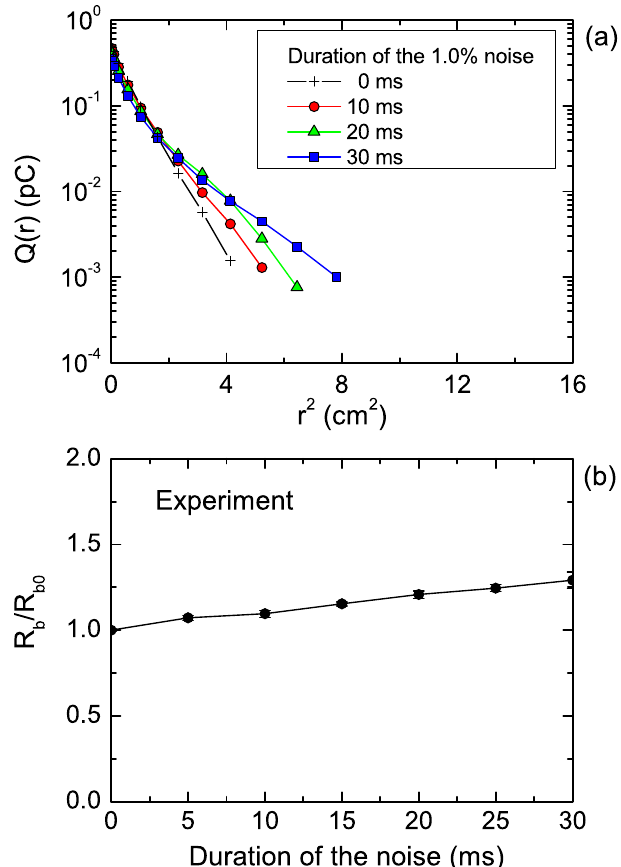
FIG. 5. (Color) Evolution of (a) the measured radial profile, and (b) the corresponding rms radius under the influence of 1% uniform white